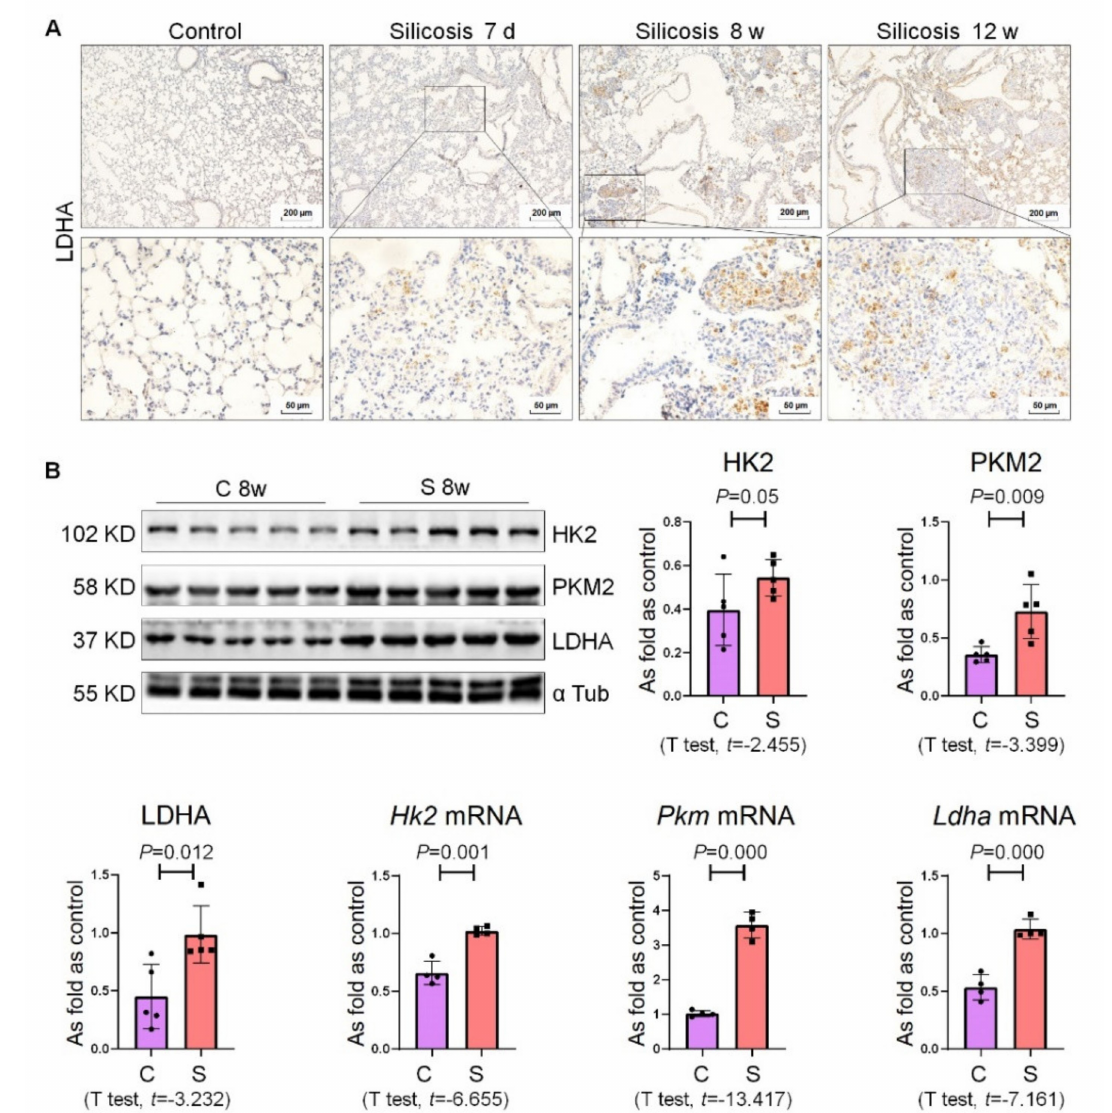
Figure 3. Enhanced glycolysis is the crucial metabolic characteristic of silicotic mice. ( A ) Expression of LDHA in silicotic mice measured by IHC staining, bars = 200 µ m or 50 µ m. ( B ) Protein and mRNA expression levels of HK2, PKM2, and LDHA in mouse lungs measured by Western blotting and qRT-PCR. Data are presented as the mean ± SD. n = 5 or 4 per group. C: control 8 w; S: silicosis 8